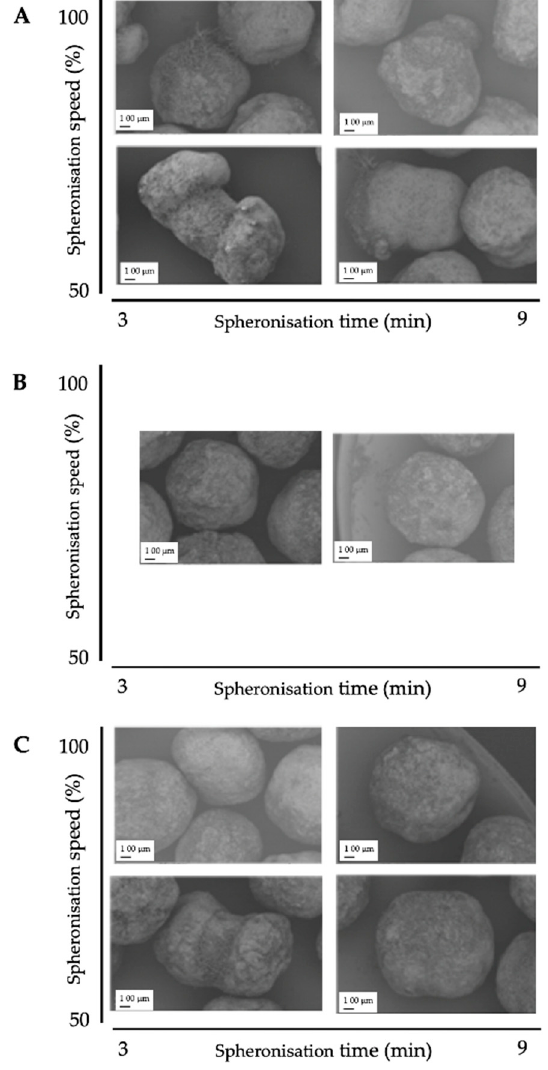
Figure 9. SEM pictures of spheronised NAM: MCC-particles after DoE for spheronisation process with the highest spheroniser load (65 g) ( A ), midpoint of the spheroniser load (40 g) ( B ) and the lowest spheroniser load (15 g) ( C ) with varying spheronisation speed ( y -axis) and time ( x -axis).